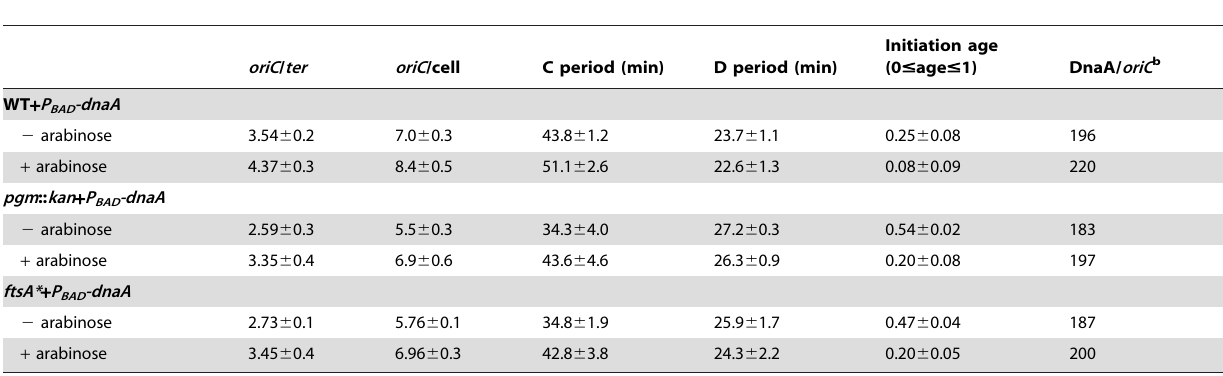
Table 2. Cell cycle parameters of E. coli strains overexpressing DnaA corresponding to Figure 4E.